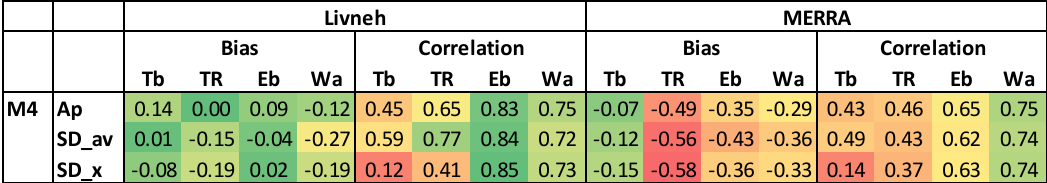
Figure 6. Performance of snowmelt models (median of catchments) with the SCE calibrated soil parameters and with snow parameters estimated without using discharge data. Results for catchments with more than 40% of precipitation falling as snow. The cells were color-coded using a green (good performance)—yellow—red (bad performance) scale. The rows show the results using three approaches for estimating the snow parameters Ap (a priori); SD_av (using SNODAS data and the daily average temperature); SD_x (using SNODAS data and the daily maximum